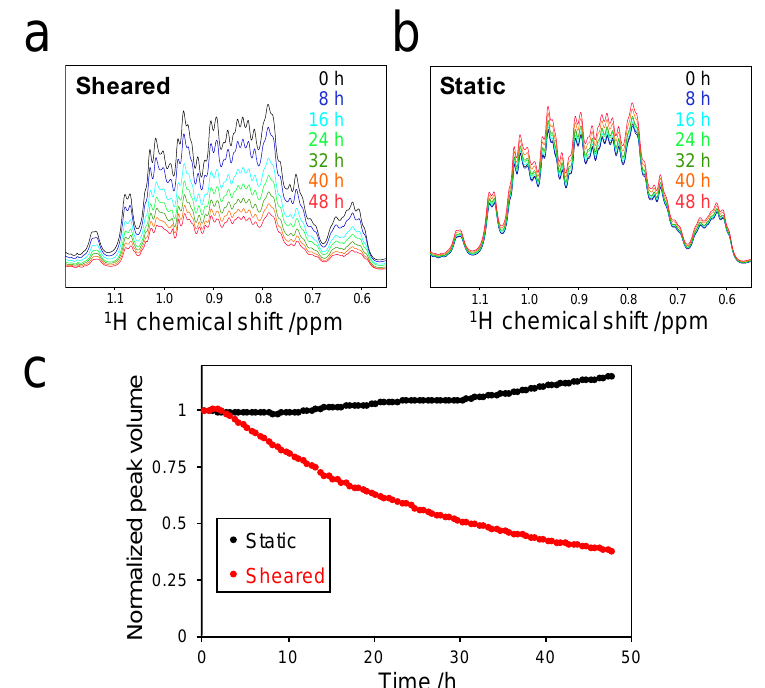
Figure 2. Decrease of soluble SOD1: Time-dependent spectral changes of methyl groups of soluble SOD1 under sheared ( a ) and static ( b ) conditions; ( c ) Real-time NMR profiles of the peak volume of the methyl groups under sheared (red) and static (black) conditions. The peak volume was calculated by the integration of the peaks in the 1 H chemical shift range of 0.55 to 1.20 ppm and normalized by the initial peak volume.